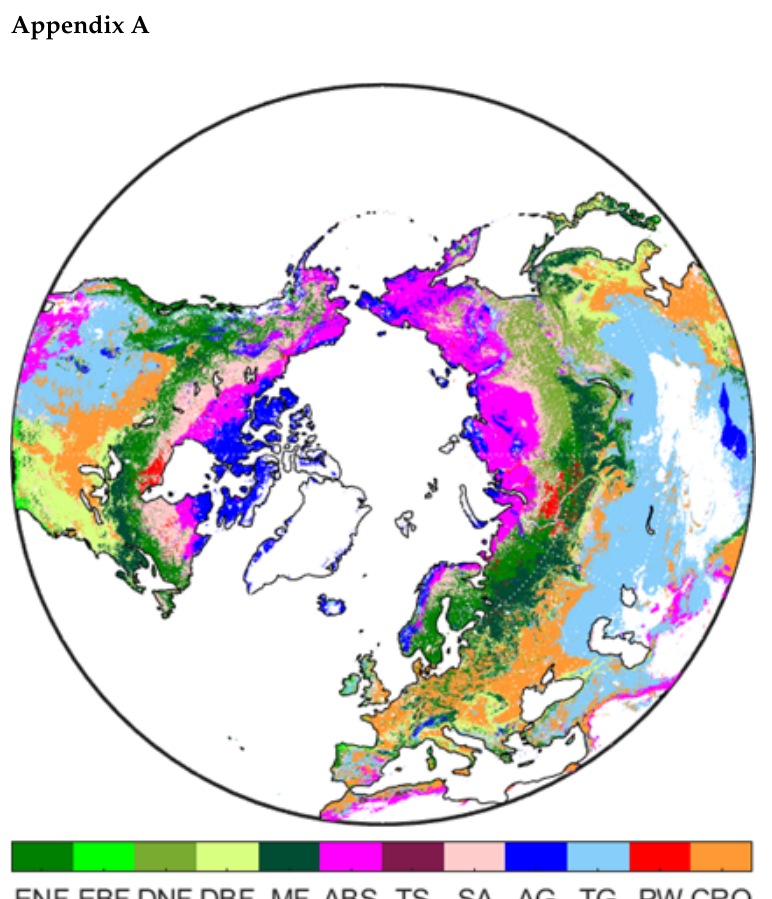
Figure A1. In total, 12 biomes comprise the study area—Evergreen Needleleaf Forests (ENF), Ev- ergreen Broadleaf Forests (EBF), Deciduous Needleleaf Forests (DNF), Decidous Broadleaf Forests (DBF), Mixed forests (MF), Arctic and Boreal Shrublands (ABS), Temperate Shrublands (TS), Sa- vannas (SV), Arctic Grasslands (AG), Temperate Grasslands (TG), Permanent Wetlands (PW), and Croplands